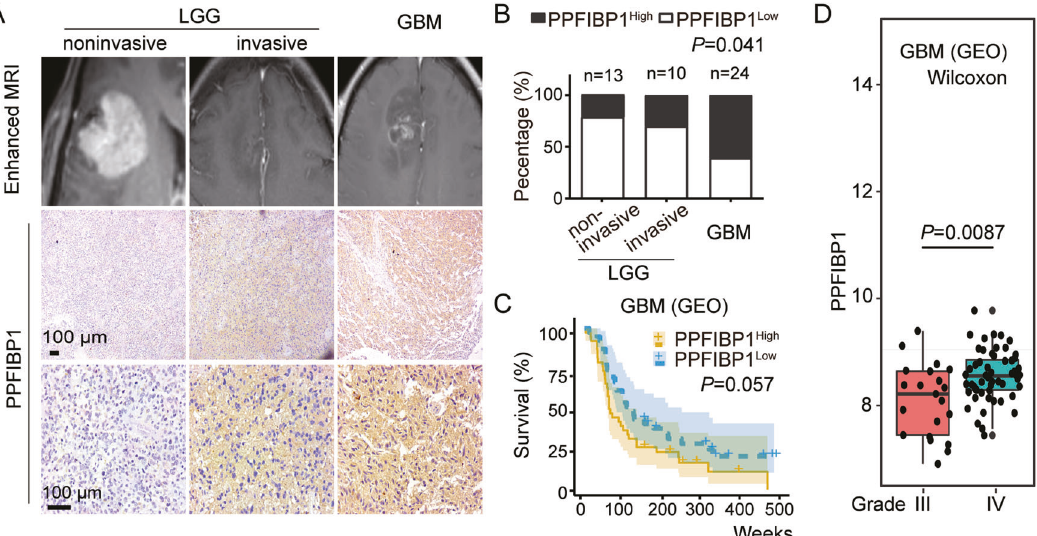
Fig. 1 PPFIBP1 expression and its correlation with invasion and survival in glioma patients. A Top: representative MRI images of patients with LGG and GBM. Middle and bottom: low and high magni fi cation of glioma tumor sections of patient stained with a PPFIBP1 antibody. B PPFIBP1 expression levels in glioma specimens from 47 glioma patients. Statistical difference between LGG noninvasive, LGG invasive, and GBM was evaluated with Fisher ’ s exact test. C Kaplan – Meier curves show the overall survival of 77 GBM patients, of which 38 are with high level of PPFIBP1 and 39 are with low level of PPFIBP1. Data were obtained from GEO database (GSE4271). D The boxplot shows the expression levels of PPFIBP1 in patients with different grades of the same data set from GEO database (GSE4271), P value is determined by Wilcoxon signed-rank test. The fi gures are representative data from at least three independent